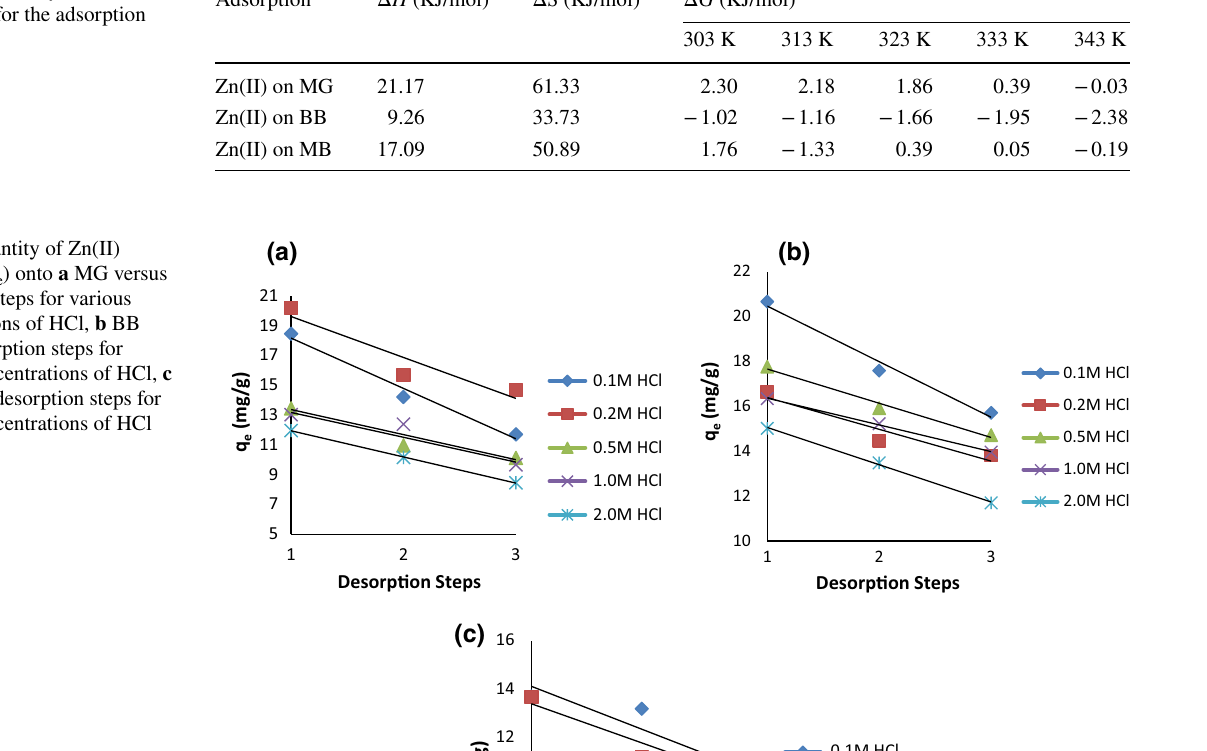
Table 3 Thermodynamic parameters for the adsorption of Zn(II)